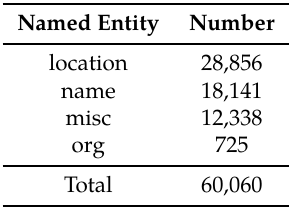
Table 6. Total number of named entities in the test set.